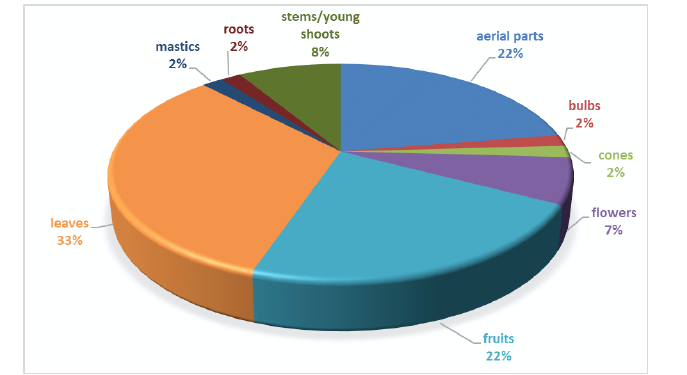
Figure 6 Distribution of the parts of edible plants